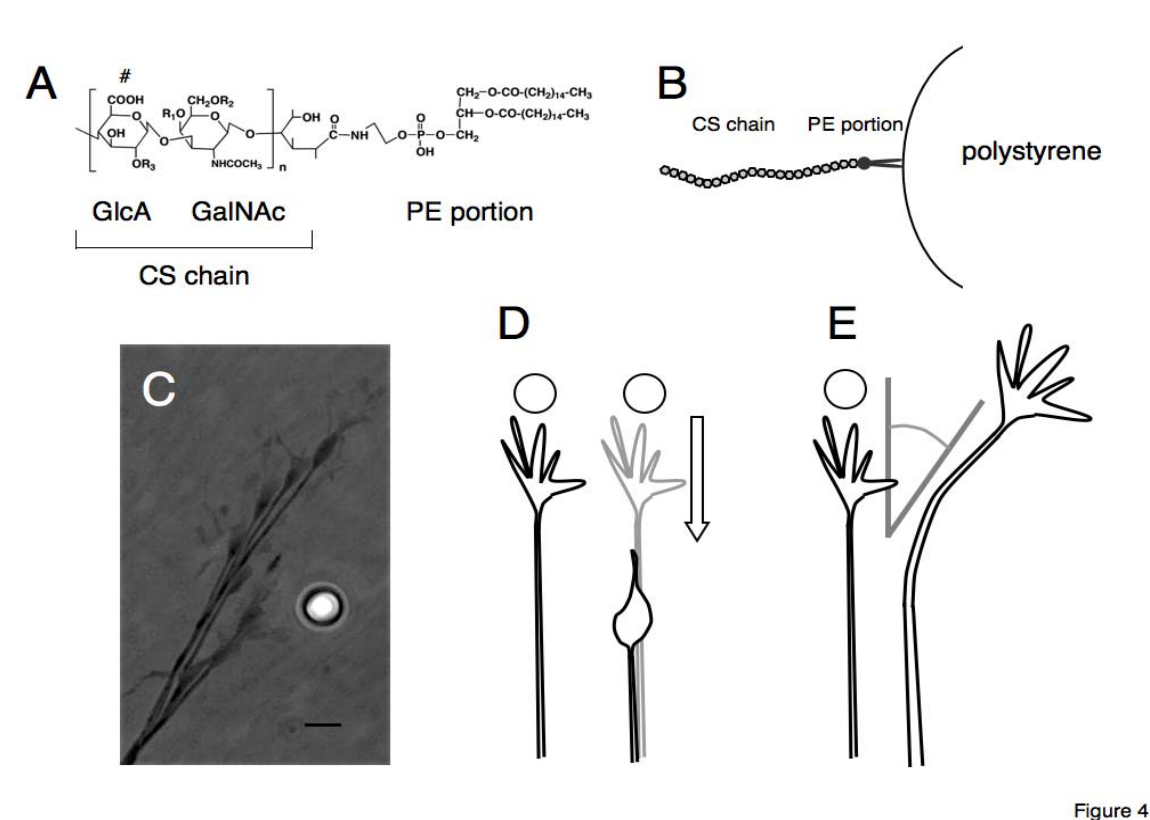
Figure 4. Schematic drawings of lipid-derivatized CS (CS-PE) ( A ) and CS-PE bead ( B ). The reducing end of the CS chain is coupled with an amino group of phosphatidylethanolamine to generate CS-PE ( A ). The CS-PE hydrophobically adheres on the surface of polystyrene beads, forming the CS-PE beads with CS chains arranged outwardly ( B ). Behavior of a retinal growth cone encountering a CS-PE bead is shown in a photomontage of time-lapse images ( C ). Typical behaviors of the retinal growth cones encountering CSE-PE beads are shown in ( D ) retraction and ( E ) turning away from the